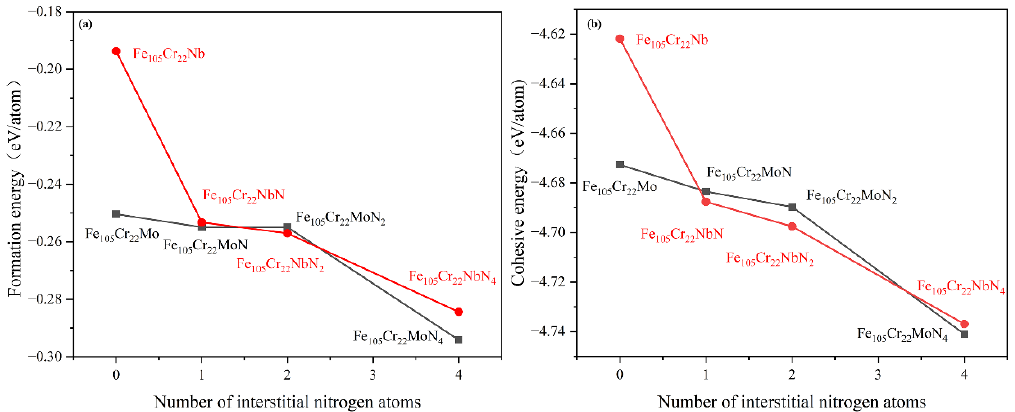
Figure 3. Variation of ( a ) formation energy and ( b ) cohesion energy of stainless steel with different nitriding degrees. nitriding degrees.